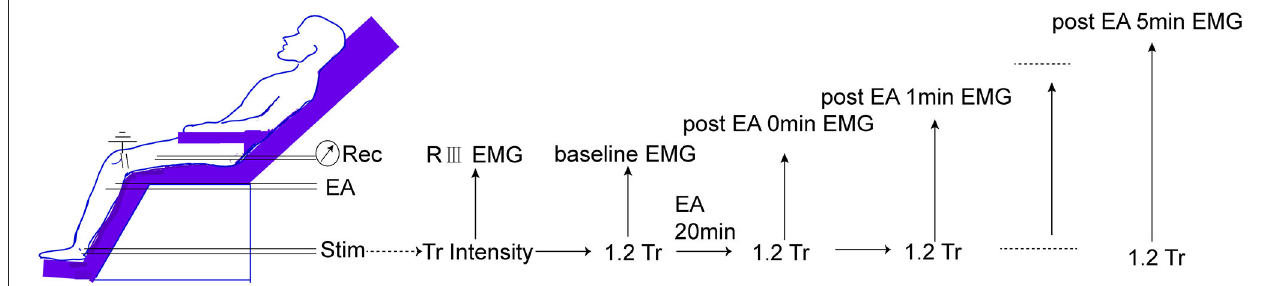
FIGURE 4 | Measurement of RIII reflex-induced EMG. The threshold of RIII reflex (Tr) is determined according to high intensities of peroneal nerve stimulation. Then, 1.2 Tr peroneal nerve stimulus is conducted every 1min before and after 0–5min of